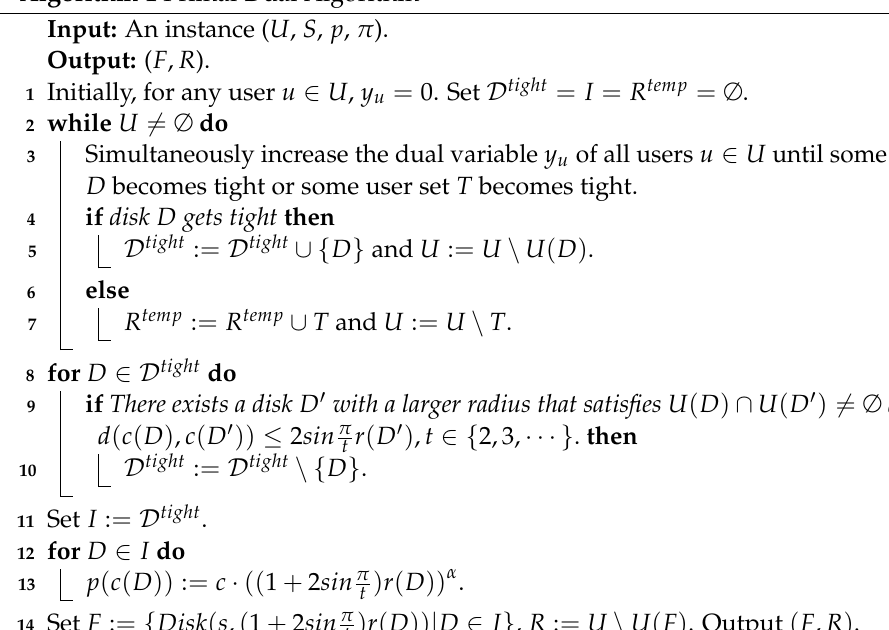
Algorithm 1 Primal Dual Algorithm